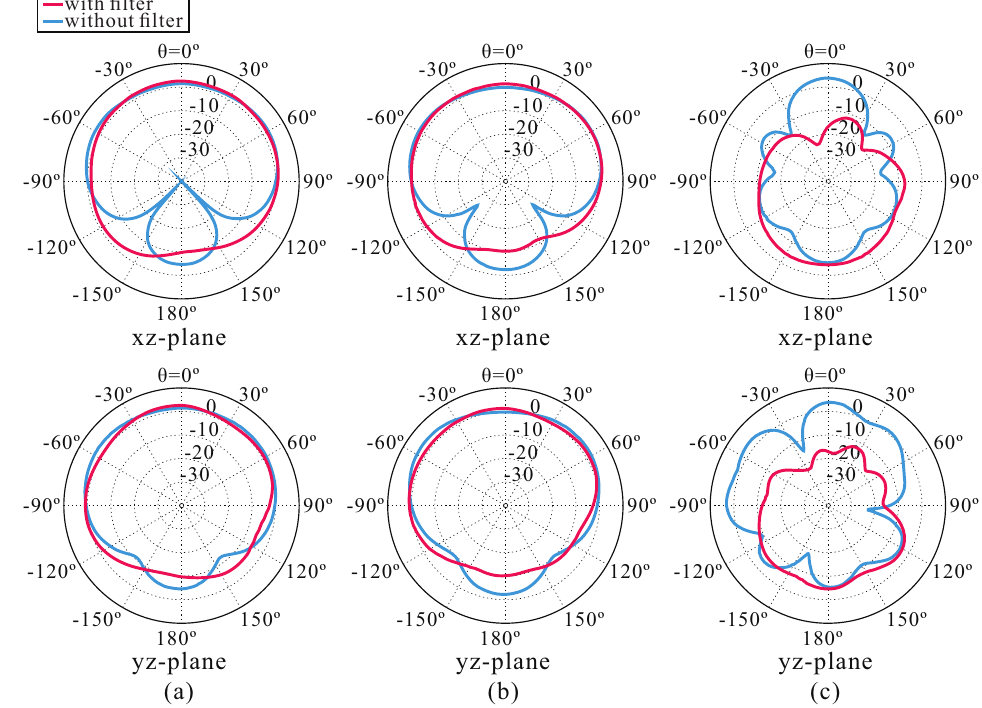
Figure 6. Simulated far-field radiation patterns of the proposed antenna with and without a filter: ( a ) 3.25, ( b ) 3.3, and ( c ) 6.5